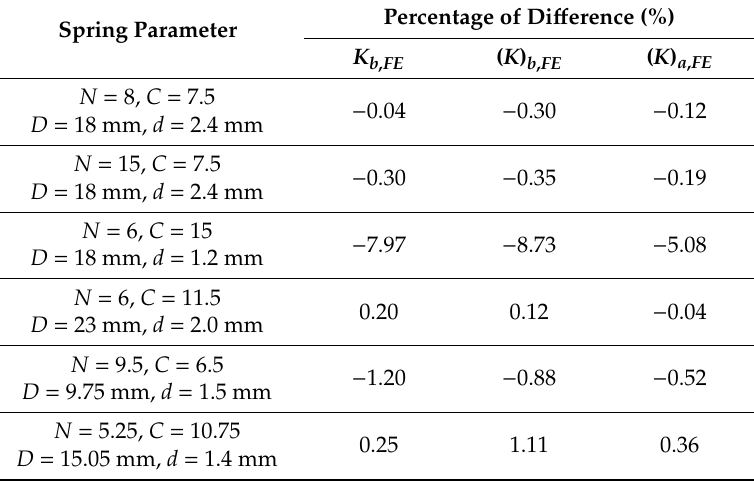
Table 5. Di ff erence between curvature correction factor ( K ) obtained through FE method against surface-fitted equation. Percentage of Di ff erence (%) Spring Parameter K b , FE ( K ) b , FE ( K ) a , FE N = 8, C =